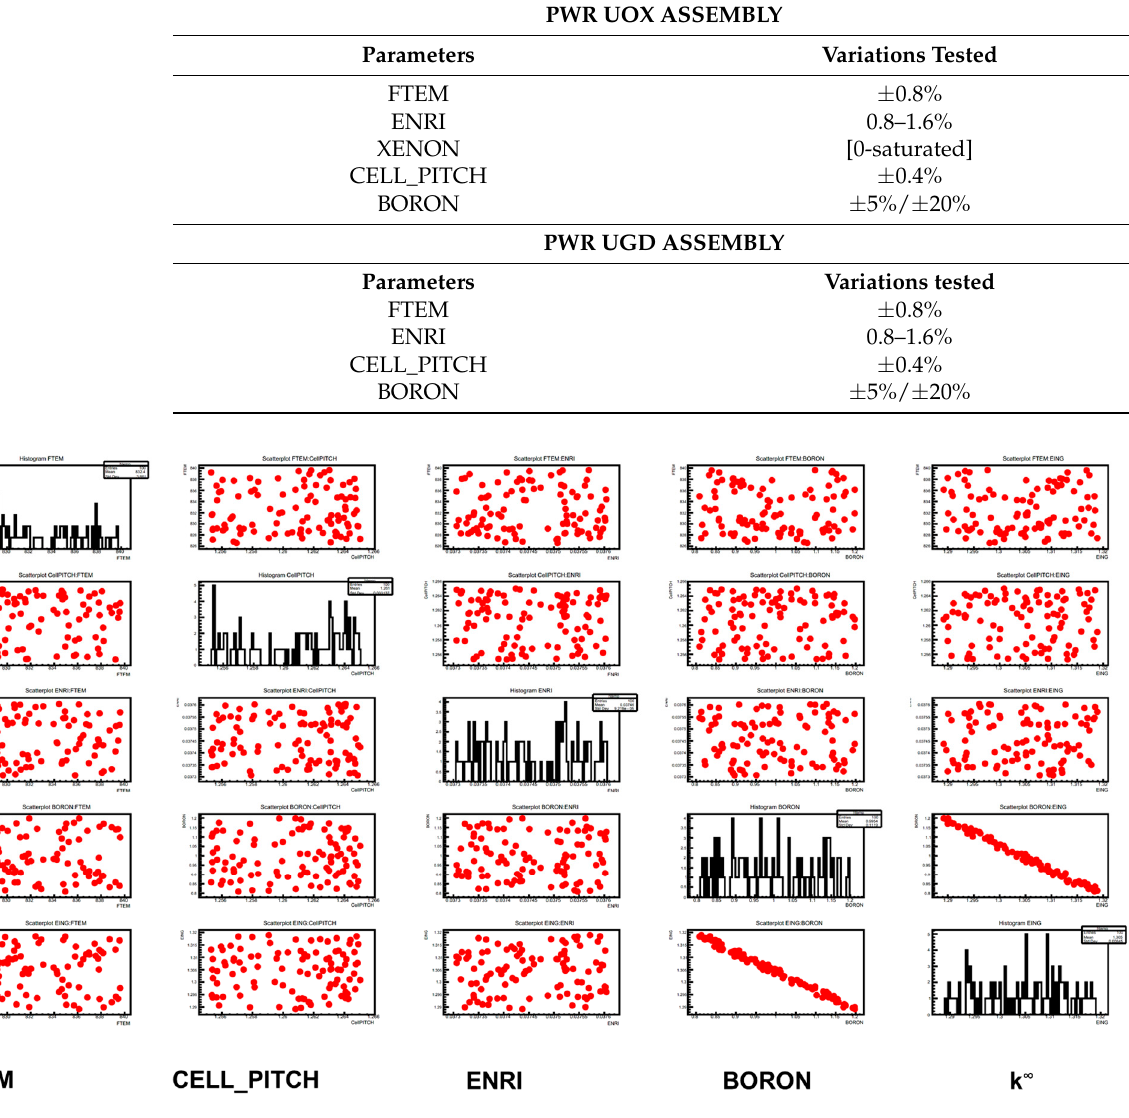
Figure 17. PWR UOX Assembly: pairs plot (FTEM, CELL_PITCH, ENRI, BORON).